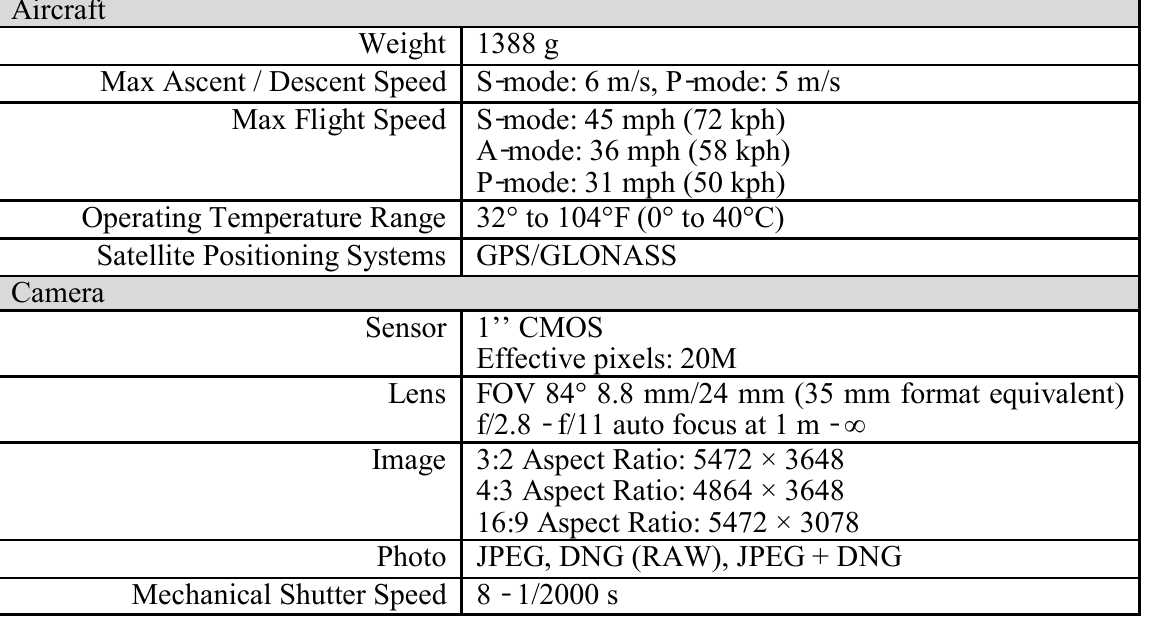
Table 2. The selected technical parameters of UAV Phantom 4